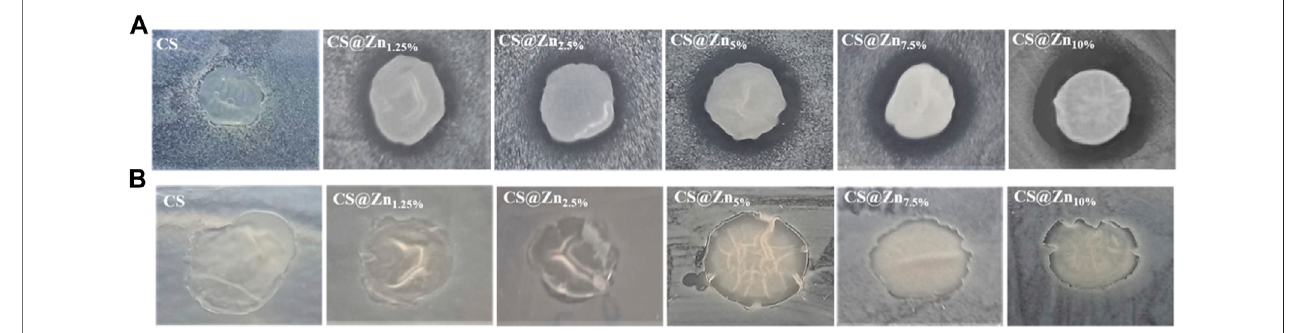
FIGURE 9 | Inhibitory effect of CS and CS@Zn n fi lms on the growth of Staphylococcus aureus (A) and Escherichia coli (B) .